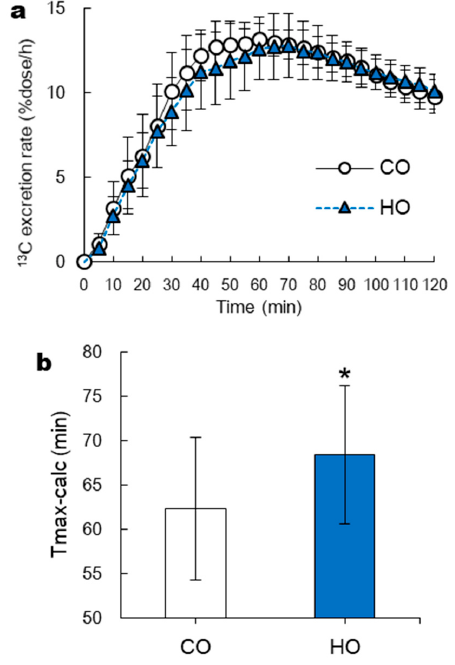
Figure 2. Time course of relative change in CSA of gastric antrum (i.e., % GE) following consump ‐ tion of pumpkin soup containing 9.2 g of either intact corn oil (CO) or heated corn oil (HO) in Ex ‐ periment 1. At 15 min after consumption of pumpkin soup, CSA of the gastric antrum was defined as 100%. Mean ± SD. * p < 0.05 (CO vs. HO).